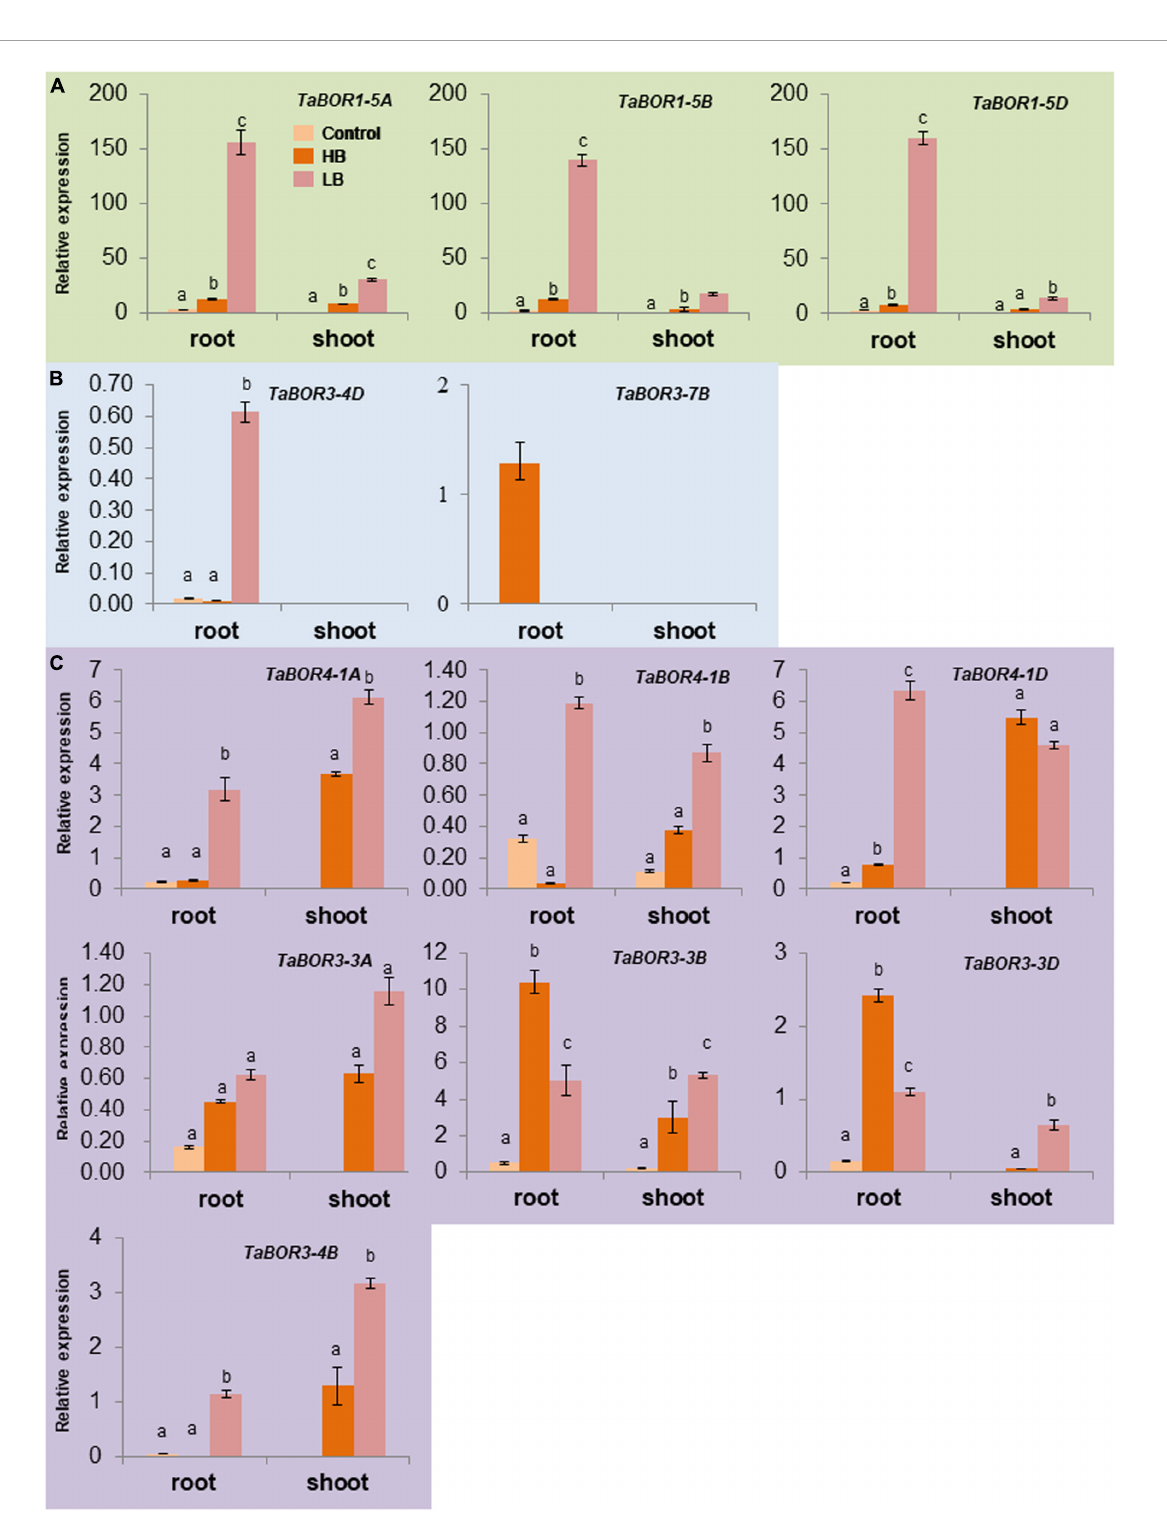
FIGURE8 Expression patterns of TaBOR genes under different B stresses. (A) TaBOR genes that were mainly expressed in roots. (B) TaBOR genes that were expressed in only roots. (C) TaBOR genes that were expressed in both shoots and roots. Different letters represent statistical significance ( p <